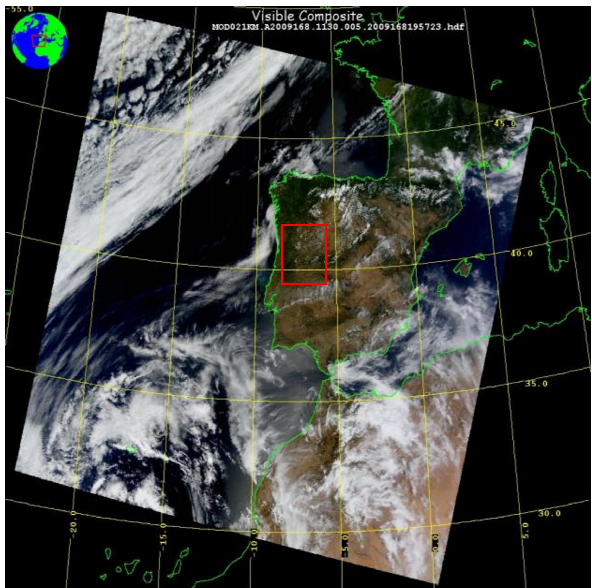
Fig. 2. Visible composite of MODIS/Terra data for 17 June 2009, 11:30–11:35UT. Source: LAADS. The red square indicates the ap- proximate position of the chosen